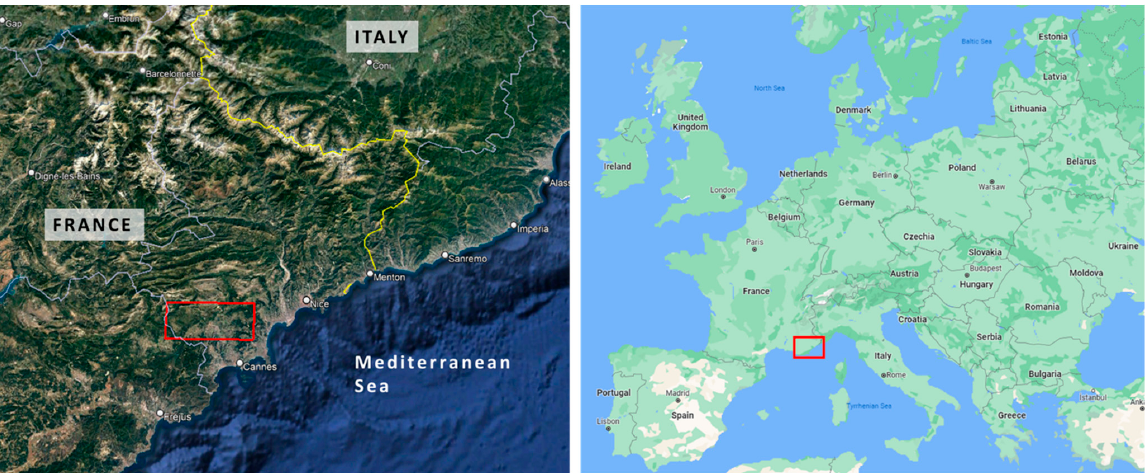
Figure 1. Area of interest identified by the red polygon, top left point: 43°43 ′ 15.86 ″ N 6°46 ′ 11.01 ″ E, bottom right point: 43°36 ′ 50.10 ″ N 7°4 ′ 45.83 ″ E in EPSG:4326/WGS84. (Google Earth).